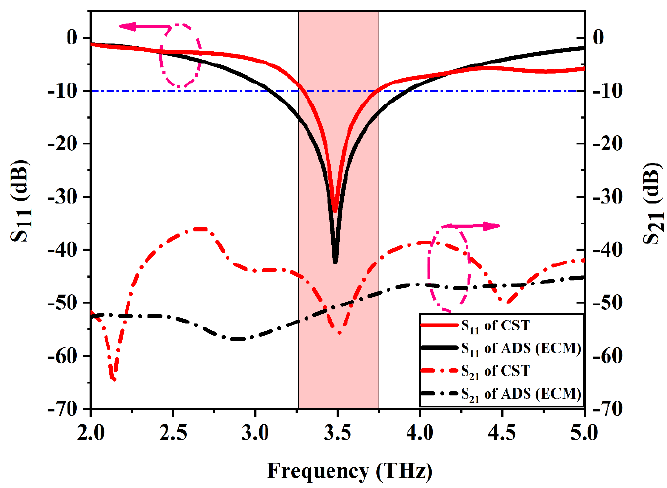
Figure 19. S − Parameters of Ant. C with CST and ADS equivalent circuit model. Figure 19. S–Parameters of Ant. C with CST and ADS equivalent circuit model.